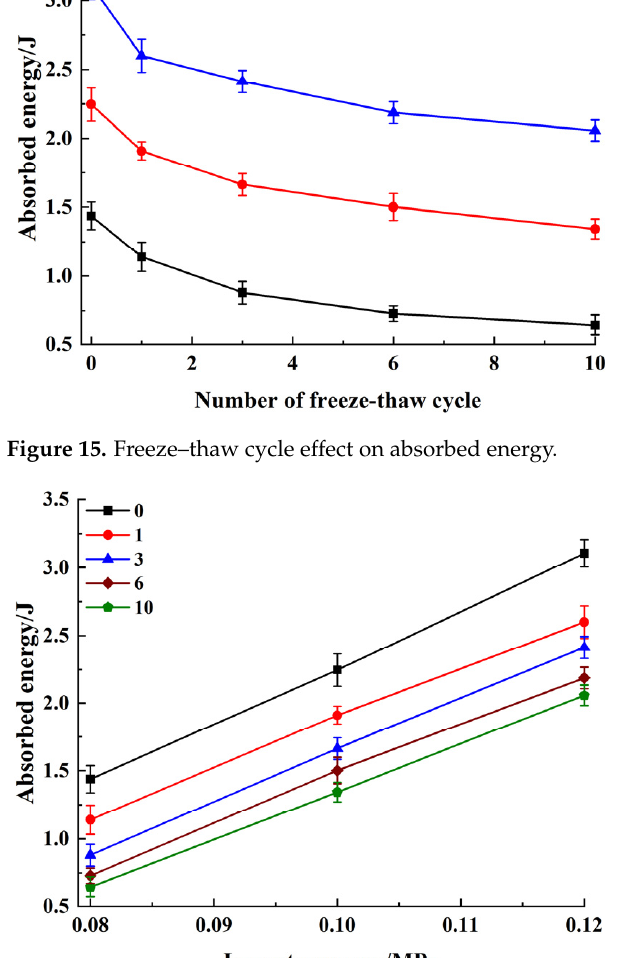
Figure 15. Freeze–thaw cycle effect on absorbed energy.